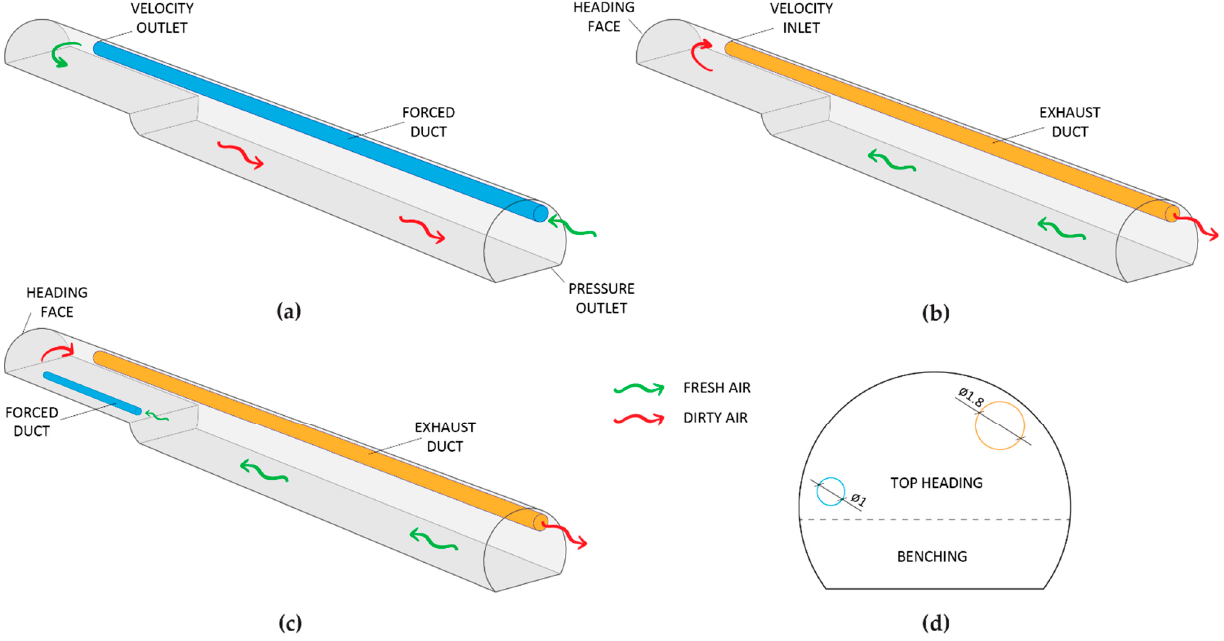
Figure 3. Schematic diagram of the ventilation systems: ( a ) forced system; ( b ) exhaust system; ( c ) mixed system; and ( d ) cross-sectional area of the mixed ventilation system.